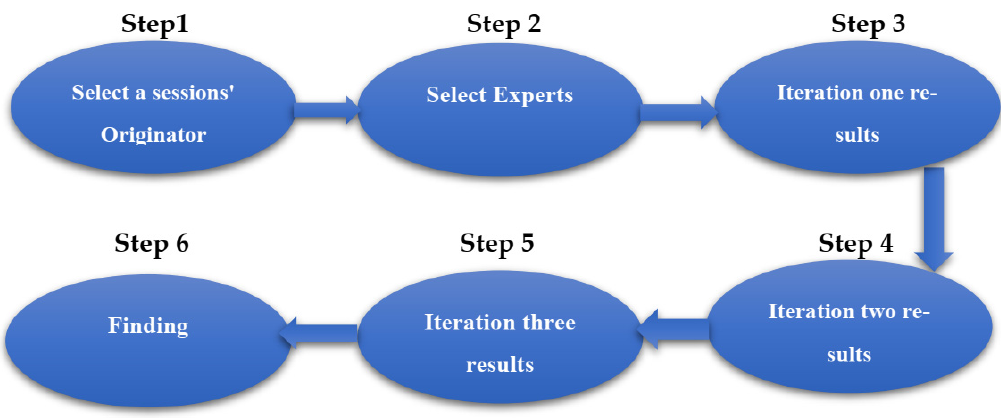
Figure 1. Delphi method steps.